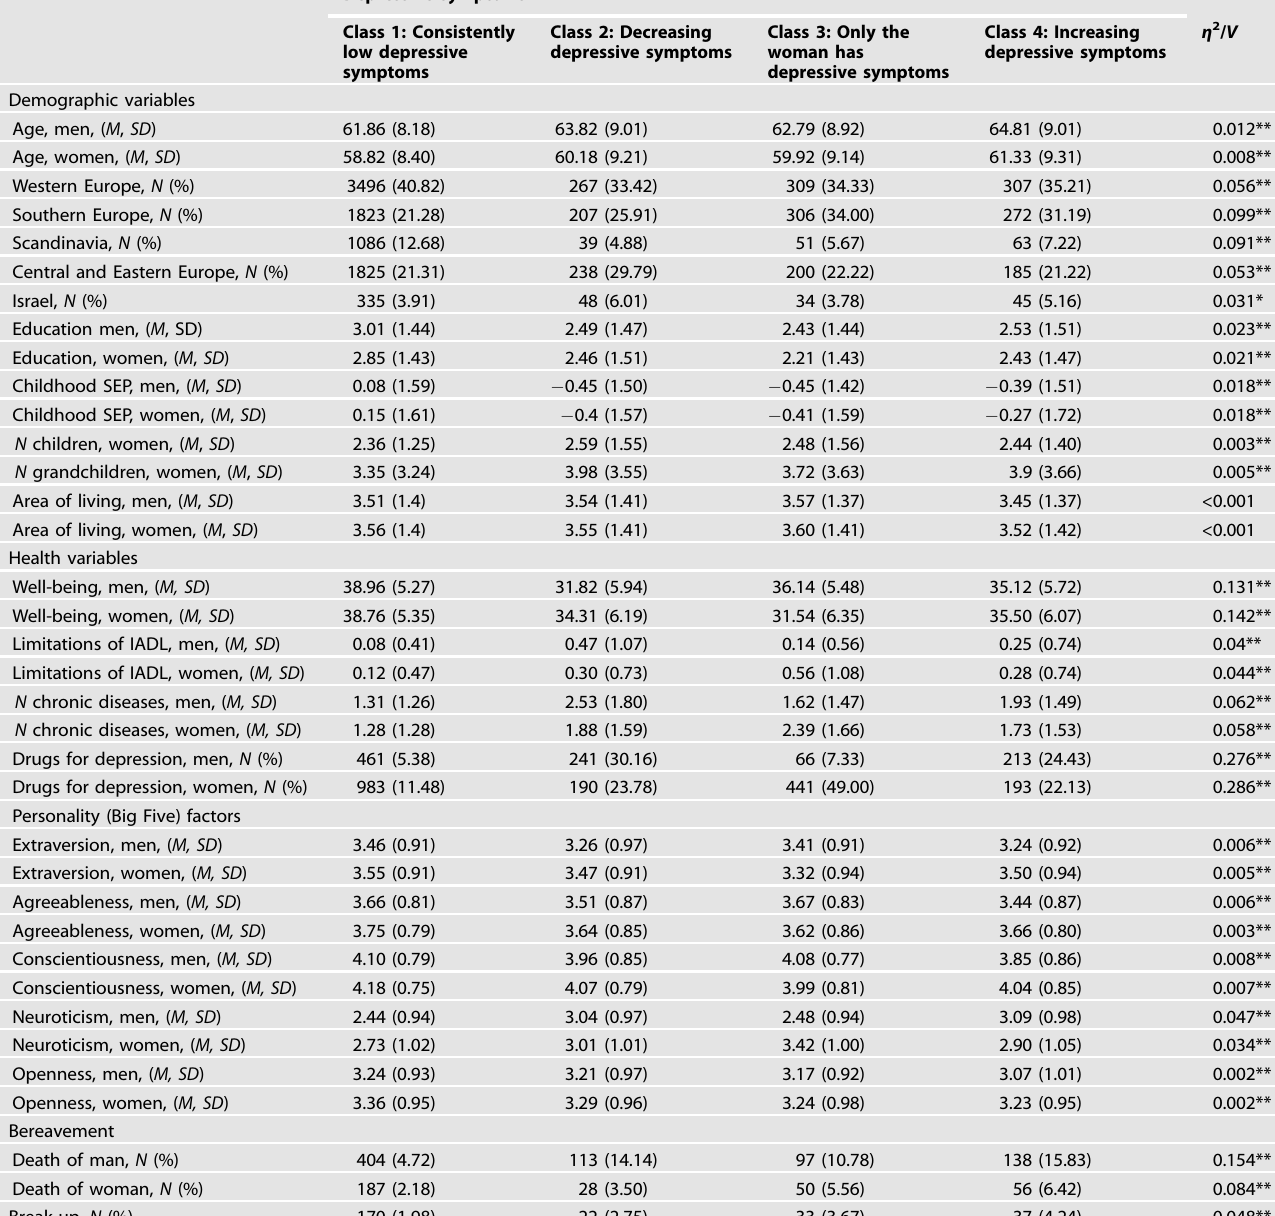
Table 2. Baseline characteristics of the participants across trajectories of depressive